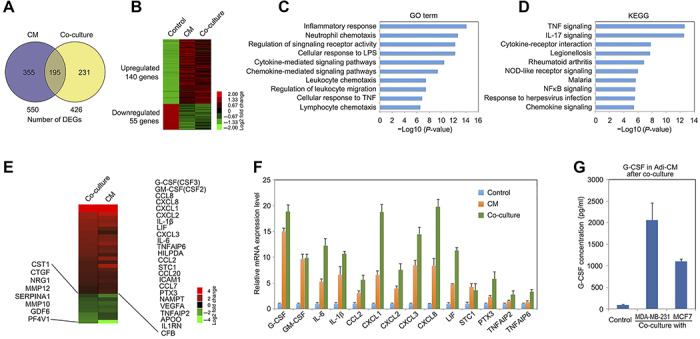
Transcriptome and secretome profiling of CAAs by RNA-Seq. (A) CAAs were generated by treatment with MDA-MB-231 cell-derived CM or co-cultured with MDA-MB-231 cells for 24 h, respectively. Then, CAAs and the untreated mature adipocytes were subjected to total RNA extraction and RNA-Seq. Gene expression level alterations with a fold change of >1.5 for upregulated genes and <0.6 for downregulated genes and with a P-value <0.05 were regarded as biologically significant. (B) Heat map classification of the 195 common DEGs from both CM-generated and co-culture-induced CAAs groups. Color-encoded relative gene expression levels are expressed in log2 scale. (C and D) GO analysis (C) and KEGG pathway enrichment (D) of the 195 DEGs. The top 10 GO terms or pathways were presented, respectively. (E) Heat map presentation of DEGs encoding secretory proteins among the common DEGs. Color-encoded relative gene expression levels are expressed in log2 scale. (F) Gene expression level detection for CAAs induced by breast cancer CM treatment or co-culture with MDA-MB-231 cells, along with control adipocytes, by RNA purification and q-PCR. (G) After co-culture of breast cancer cells and mature adipocytes in transwell for 36 h, breast cancer cells in the upper chambers were removed. Adipocytes and CAAs were further cultured with serum-free DMEM for another 24 h, and then G-CSF in the medium was quantified by ELISA.